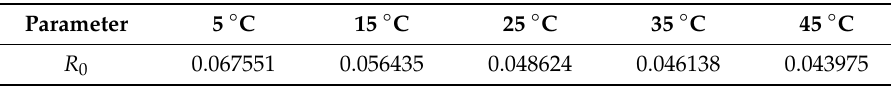
Table 4. Identification results for the ohmic internal resistance, R 0 .